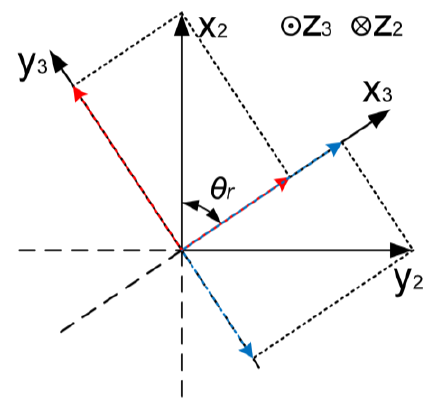
Figure 3. Geometry of 𝑥 2 𝑦 2 𝑧 2 and 𝑥 3 𝑦 3 𝑧 3 coordinate systems.